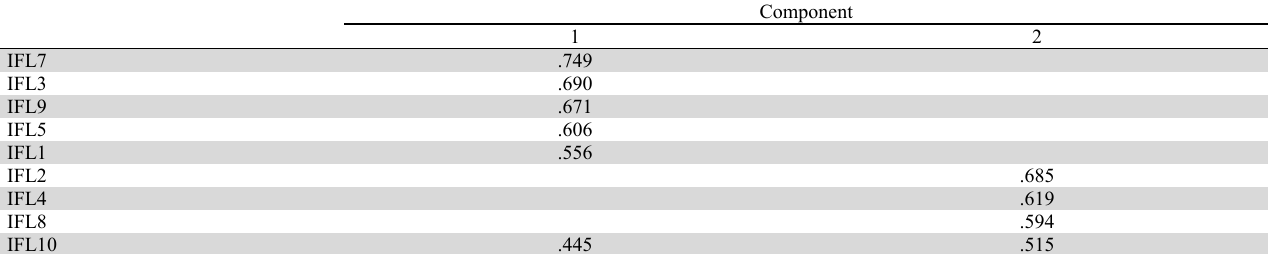
Rotated Component